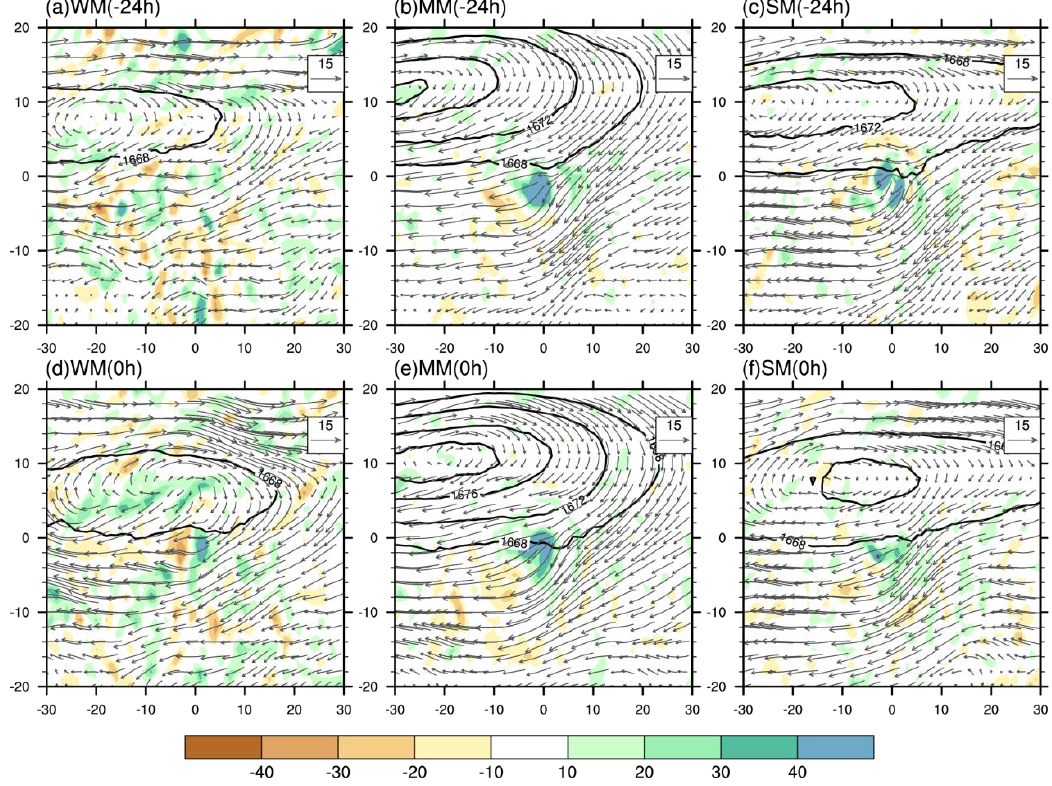
Figure 5. Same as in Figure 4, but for the 200 hPa wind fields (vector, m s − 1 ), geopotential height (contour, dam), and divergence (shaded, 10 − 6 s − 1 ).